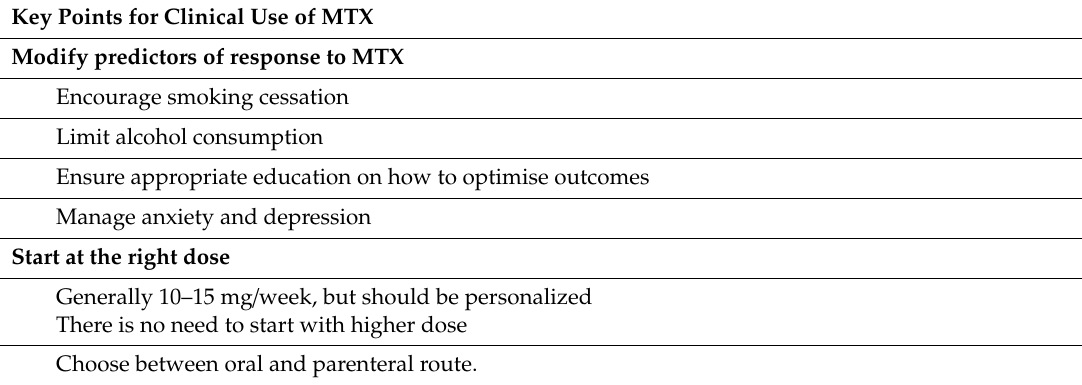
Key recommendations for clinical use of MTX. csDMARD, conventional synthetic disease-modifying antirheumatic drugs; bDMARDs, biological DMARDs; tsDMARDs, targeted synthetic DMARDs; SC,